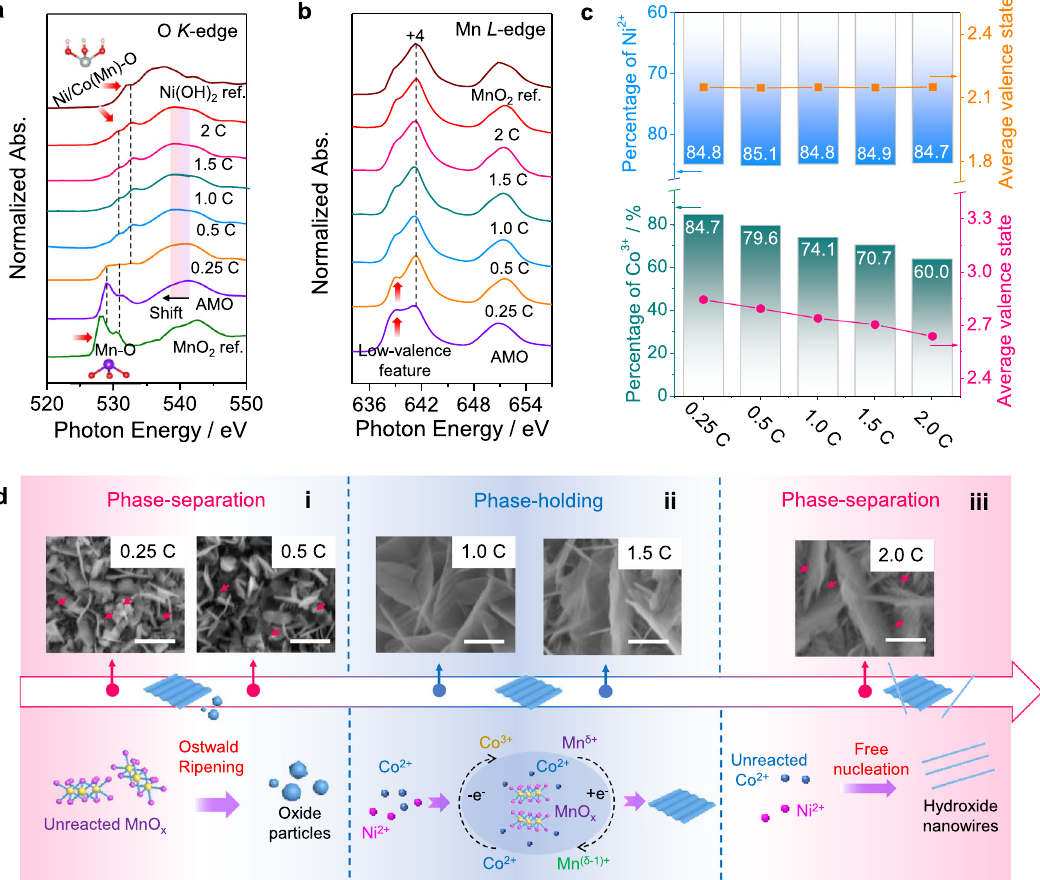
Fig. 3 Fine structure and internal electronic interaction. a O K -edge and b Mn L -edge spectra of AMO and Mn/NiCo-LDH formed at different reaction concentrations (the reaction concentration for the aforementioned Mn/NiCo-LDH is denoted as 1 C, where C represents the applied reaction concentration.); c the variation of valence states for Ni and Co at different reaction concentrations; d SEM images of the wrinkled Mn/NiCo-LDH formed at different reaction concentrations and the corresponding reaction mechanism analysis: (i) low concentration (phase-separation); (ii) moderate concentration (phase-holding) and (iii) high concentration (phase-separation). Scale bar, 400